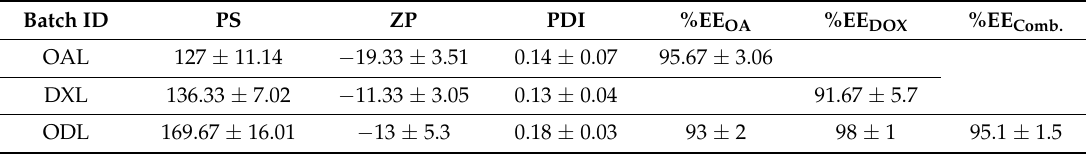
Table 2. Physicochemical attributes of liposomes prepared by REIM under preset conditions ( n =